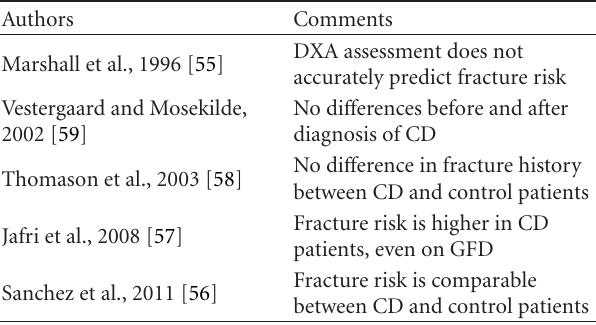
Table 3: Risk of fracture in celiac